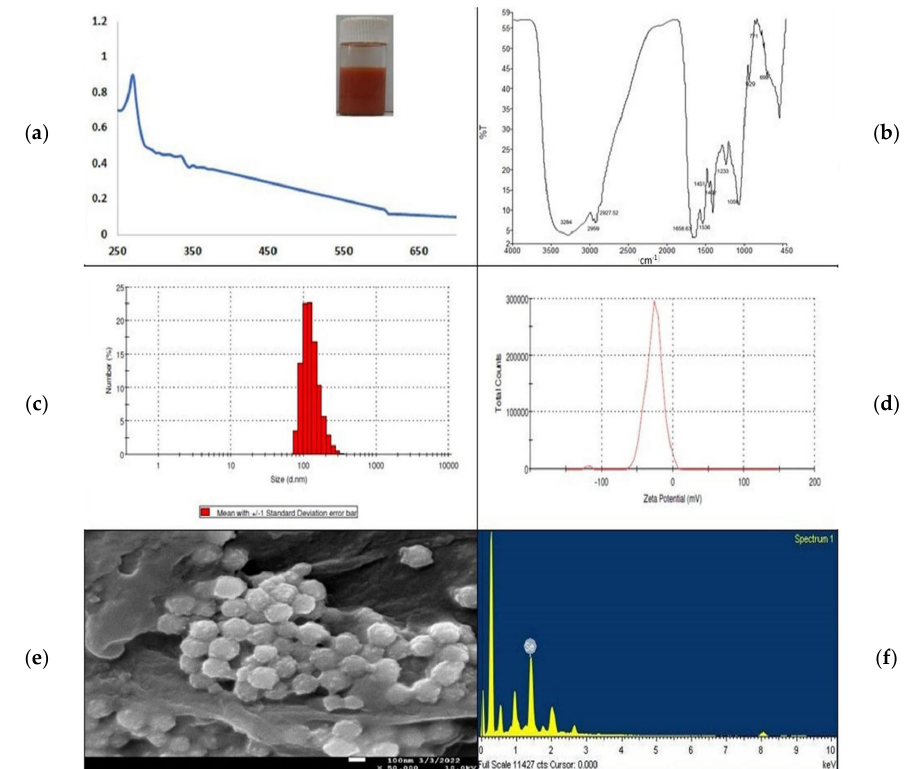
Figure 2. Characterization of selenium nanoparticles; ( a ) UV–Visible spectrum; ( b ) FTIR spectrum; ( c ) Particle size analysis graph; ( d ) Zeta potential; ( e ) FEG ‐ SEM image; ( f ) EDAX spectrum. The particle size of the biosynthesized SeNPs ranged from 78–190 nm, and the aver ‐ age particle size was found to be 172.8 nm, having a polydispersity index of 0.066 (Figure 2c), which corresponds to the homogeneity and fine dispersion with the most negligible aggregation of the nanoparticles [31,32]. Along with this, the zeta potential (Figure 2d) at − 26.9 indicates good stability of the biogenic SeNPs. The FEG ‐ SEM micrograph has the spherical shape of SeNPs with an average size between 90 and 170 nm (Figure 2e). The EDAX graph for the FEG ‐ SEM image has the characteristic peak for selenium (Figure 2f). All these outcomes confirmed the biosynthesis of spherical and stable SeNPs. 3.2. Anti ‐ Acanthamoeba Activity Selenium nanoparticles have been extensively reported for their antibacterial, anti ‐ fungal, anti ‐ viral, and insecticidal applications [33,34]. For the first time, the anti ‐ Acan ‐ thamoeba activity of these SeNPs has been studied by using the Rhizobium sp. For this, the lyophilized selenium nanomaterial was suspended in a phosphate buffer containing 0.01% starch, and different concentrations from 1.56 to 50 ppmwere tested against fifty trophozoites of Acanthamoeba and incubated for 48 h. It was observed that the SeNPs showed 50% mortality at a very high dose (LC 50 at 72 ppm) against the tested trophozoites. As Se nanoparticles are well recognized as a vehicle for drug delivery [9], and ciprofloxa ‐ cin has been reported as an effective drug for Acanthamoeba keratitis [20], the combination study of both components was designed. The conformation of the conjugate formation of SeNPs and ciprofloxacin was confirmed using a UV–Visible spectrophotometer (Shi ‐ madzu 1601, Tokyo, Japan). Standard ciprofloxacin had maximum absorbance at 271 nm